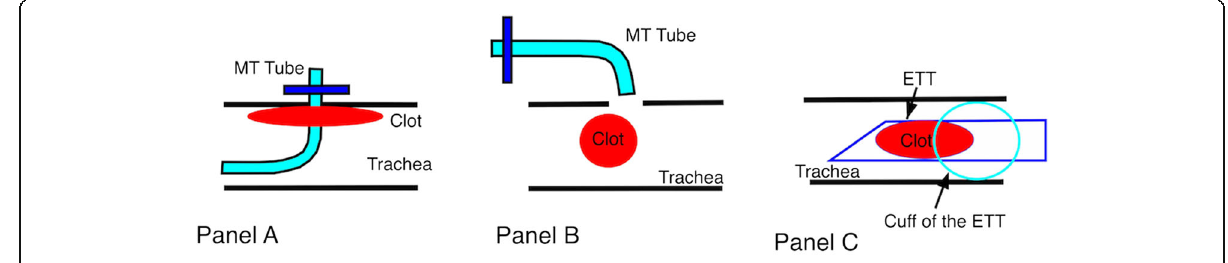
Fig. 2 Schematic of the mechanism of occlusion of the endotracheal tube. Suspected three-stage mechanism of airway obstruction. a Pre-intubation condition of the airway containing a clot around the insertion site of a mini-tracheostomy tube. b The clot falling into the trachea when the mini-tracheostomy tube was removed. c Lower airway obstruction caused by a clot. MT mini-tracheostomy, ETT endotracheal